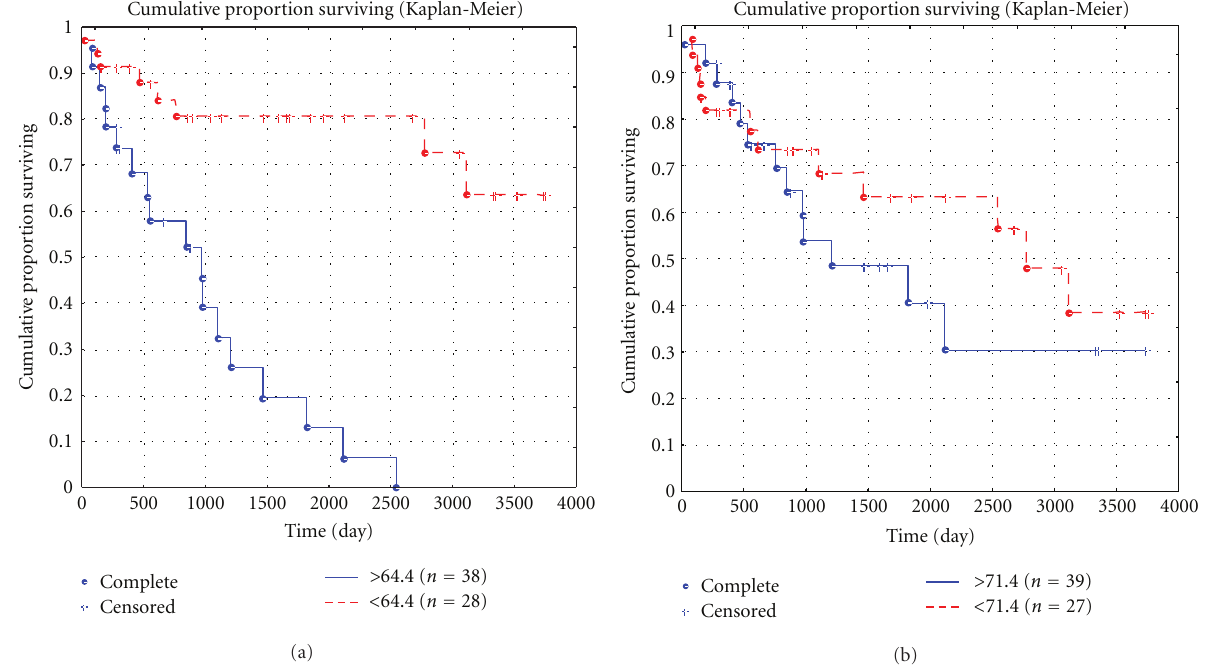
Figure 7: Cumulative proportion of 10-year survival of LMS patients, depending on the MVD in the PA (a) and the MVD in the tumor